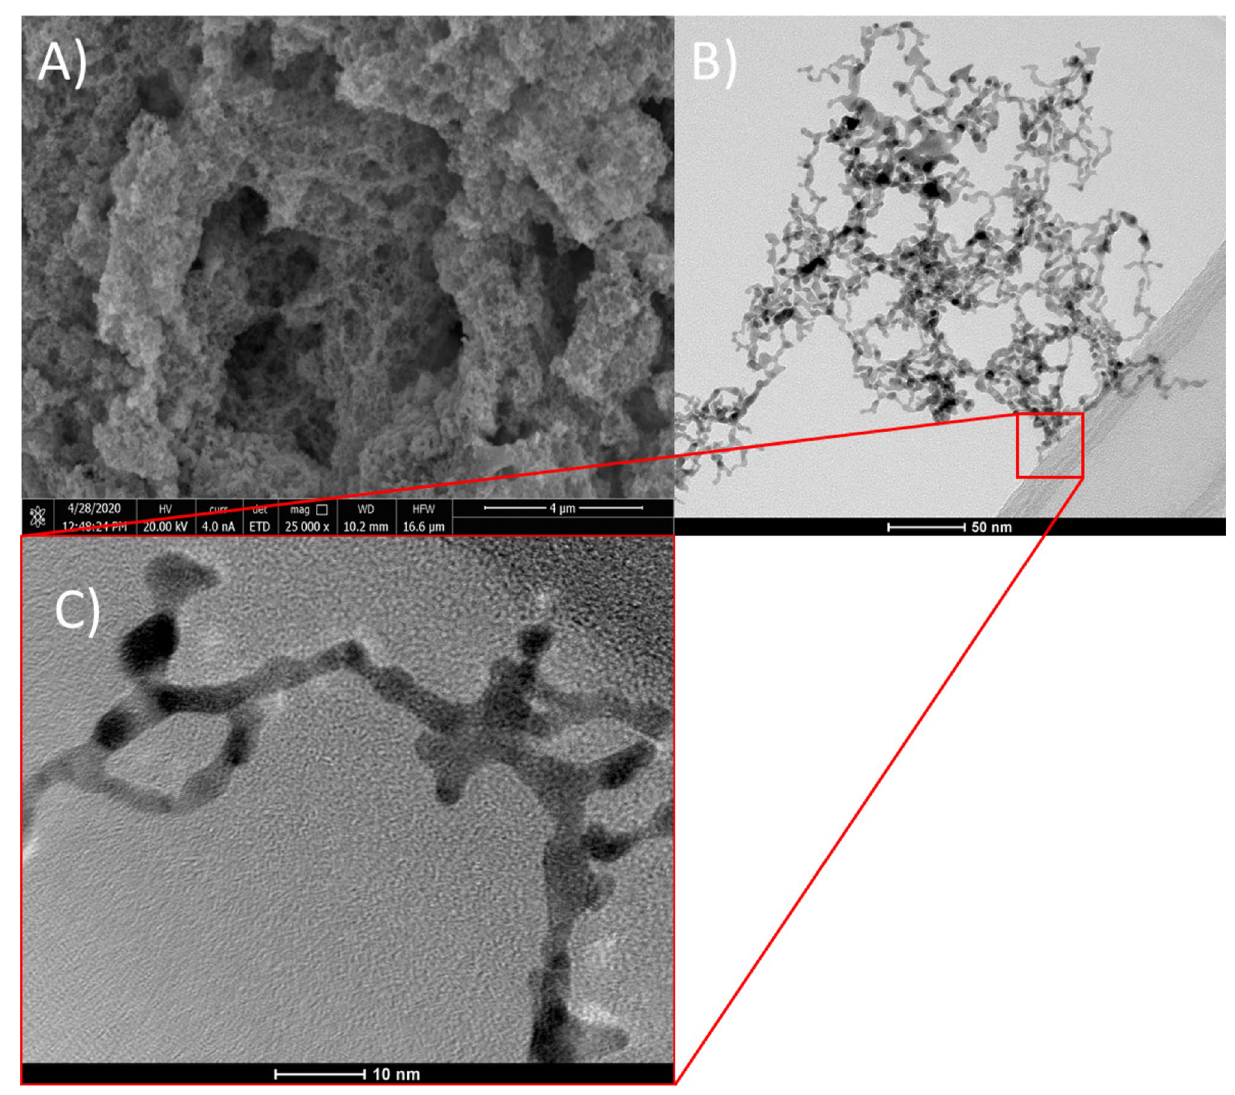
Figure 14. The sponge-like structure obtained when [Pt(IV)] = 5 × 10 −4 M, [TSC] = 10 × [Pt(IV)] M, t = 10 min, T max = 225 °C: ( A ) SEM micrograph; ( B ) and ( C ) HR-TEM